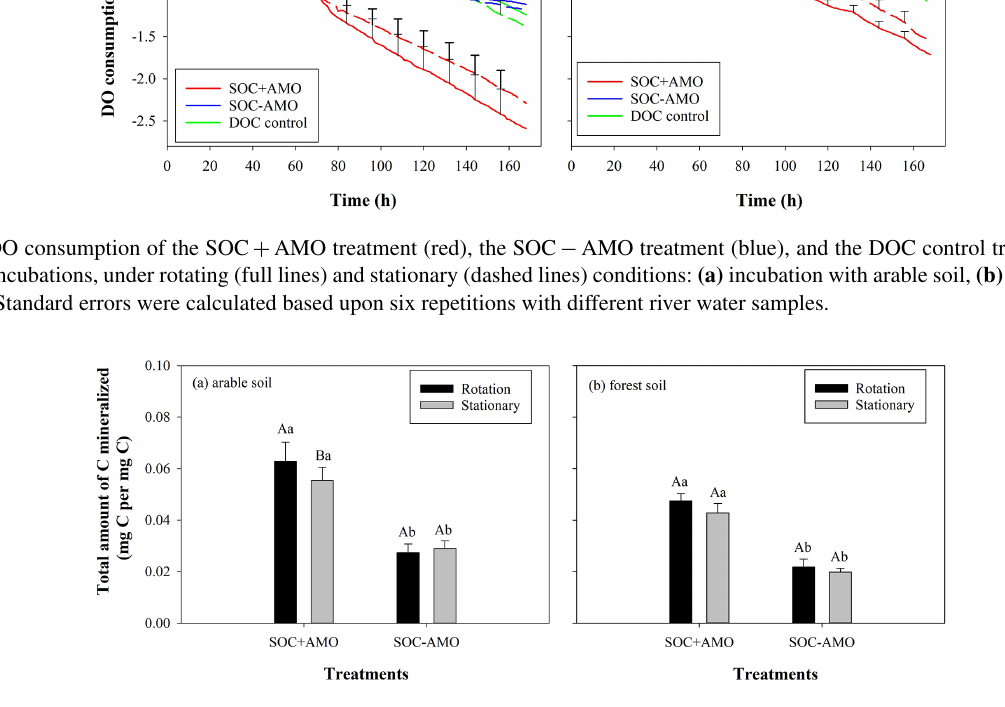
Figure 4. Total amount of C mineralized during the incubations with and without AMO under rotation and stationary conditions with (a) arable soil and (b) forest soil. Different capital letters indicate significant differences between treatments under rotation and stationary conditions at p < 0 . 05; different lowercase letters indicate significant differences between treatments with and without AMO at p < 0 . 01.